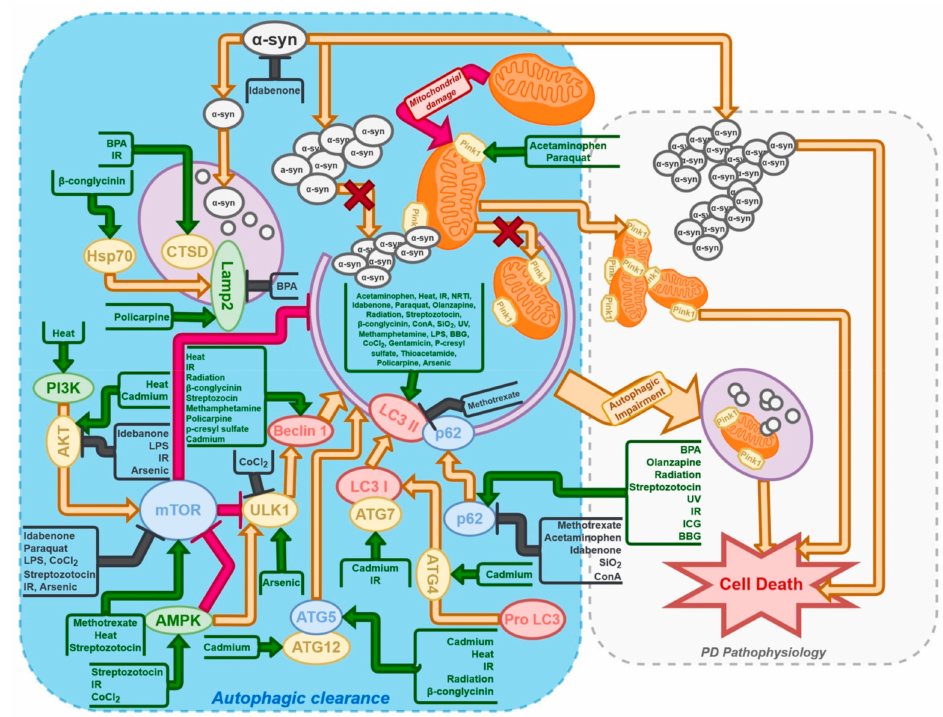
Figure 1. Diagram presenting modulation of the autophagy pathway in mammalian nerve cells induced by factors used to establish a research PD model. The green arrows indicate induction of mRNA/protein expression, whereas the red arrows indicate an inhibitory effect of the presented com- pounds. Additionally, the protein–protein interactions are shown, in which the yellow arrows indicate induction of mRNA/protein expression, whereas the black arrows indicate an inhibitory